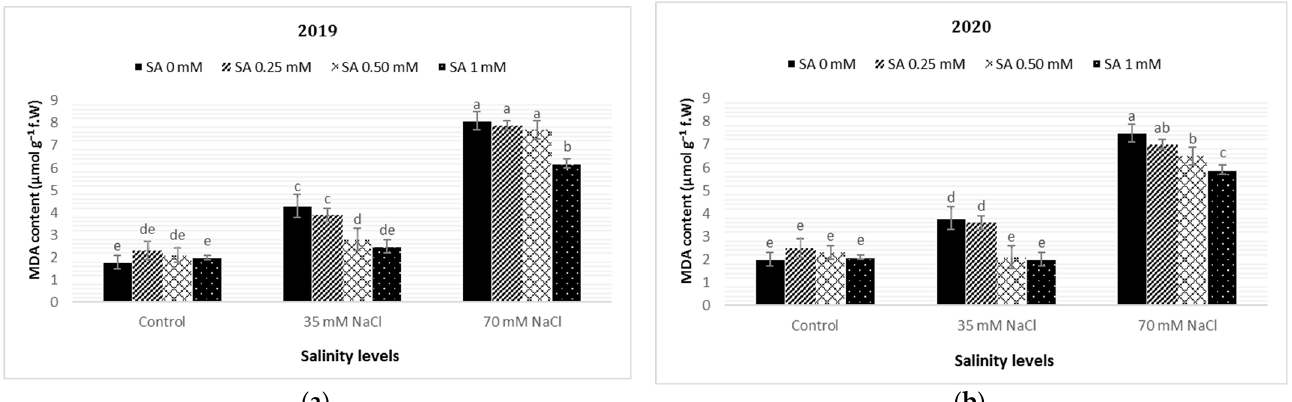
Figure 3. Malondialdehyde (MDA) content in pomegranate plants cv. “Wonderful” subjected to different salicylic acid (SA) treatments under salinity stress conditions in 2019 ( a ) and 2020 ( b ). The vertical bars with different letters are statistically different, indicating an interactive effect of salicylic acid treatments and salinity levels according to LSD test ( p < 0.05). Vertical bars indicate the mean ± SE.